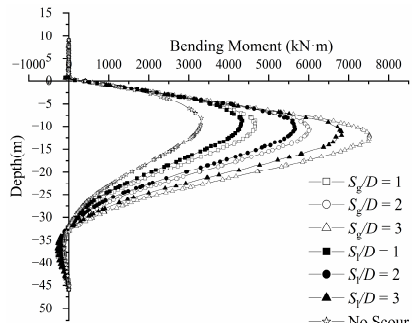
Figure 9. Bending moment along the pile length for case of different local and global scour depth.